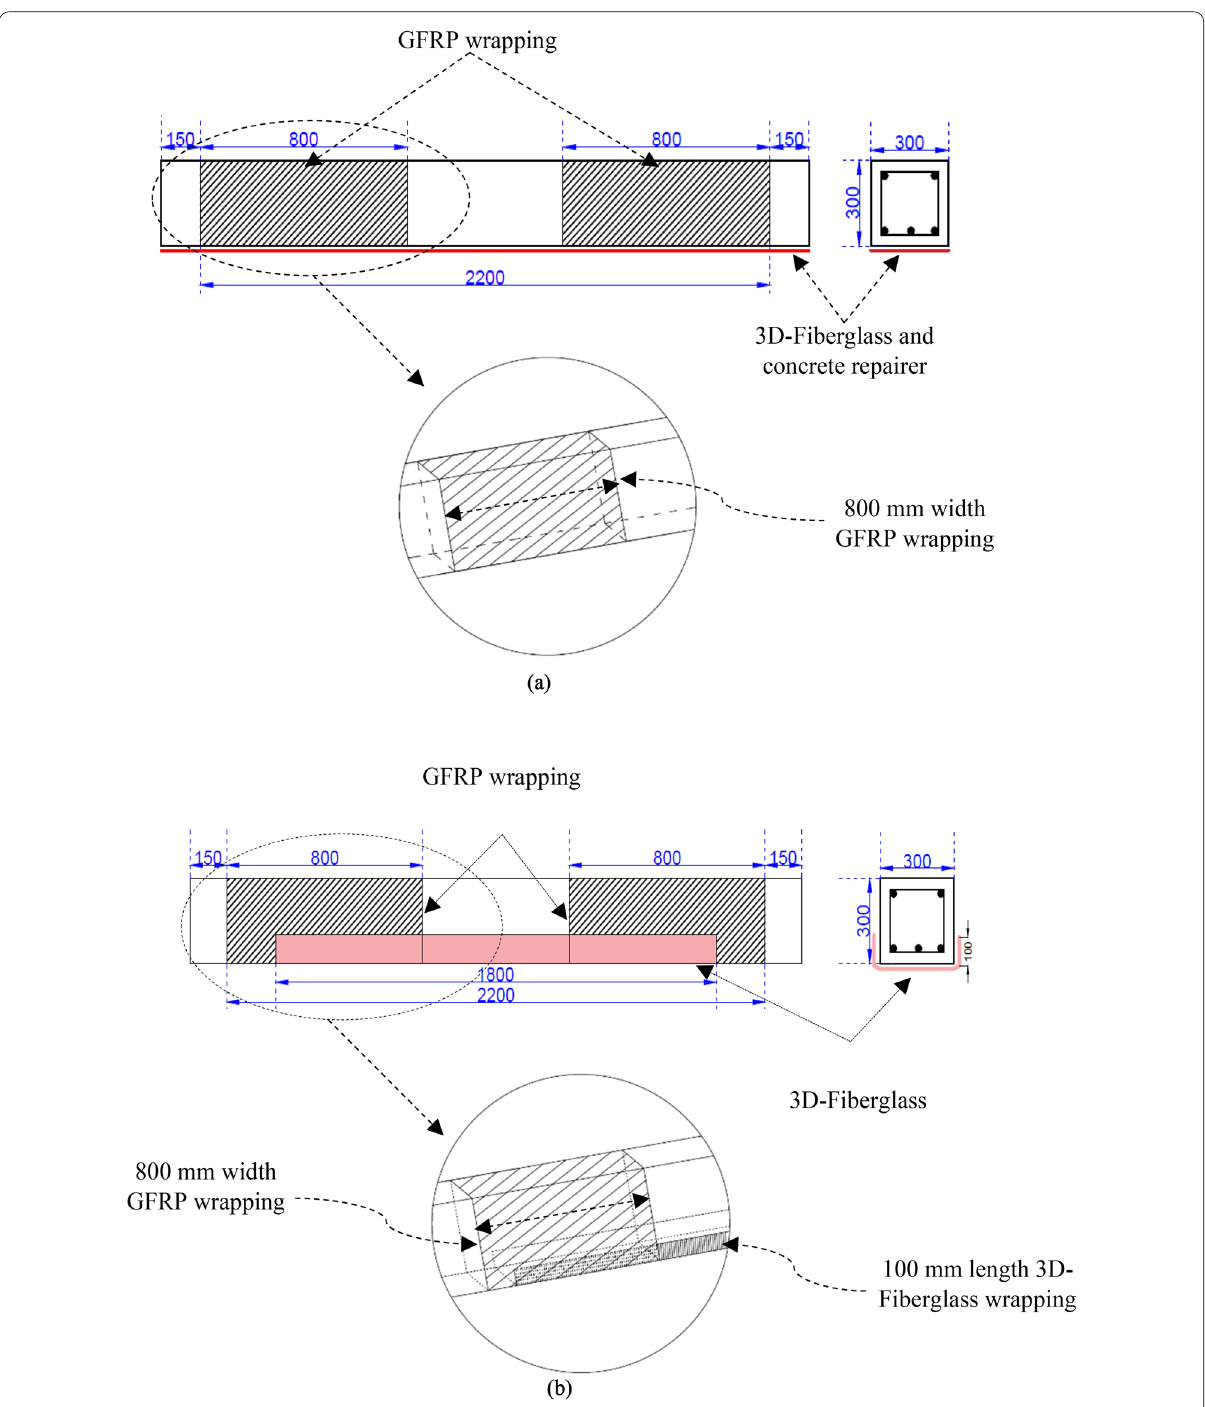
Fig. 14 Details of the additional tested beams: a details of R3DTG specimen, with concrete repairer injected into the 3D-fiberglass, and b details of R3DTRB specimen, typical wrapping of 3D-fiberglass at bottom and extended on sides with GFRP wrapping (dimensions in